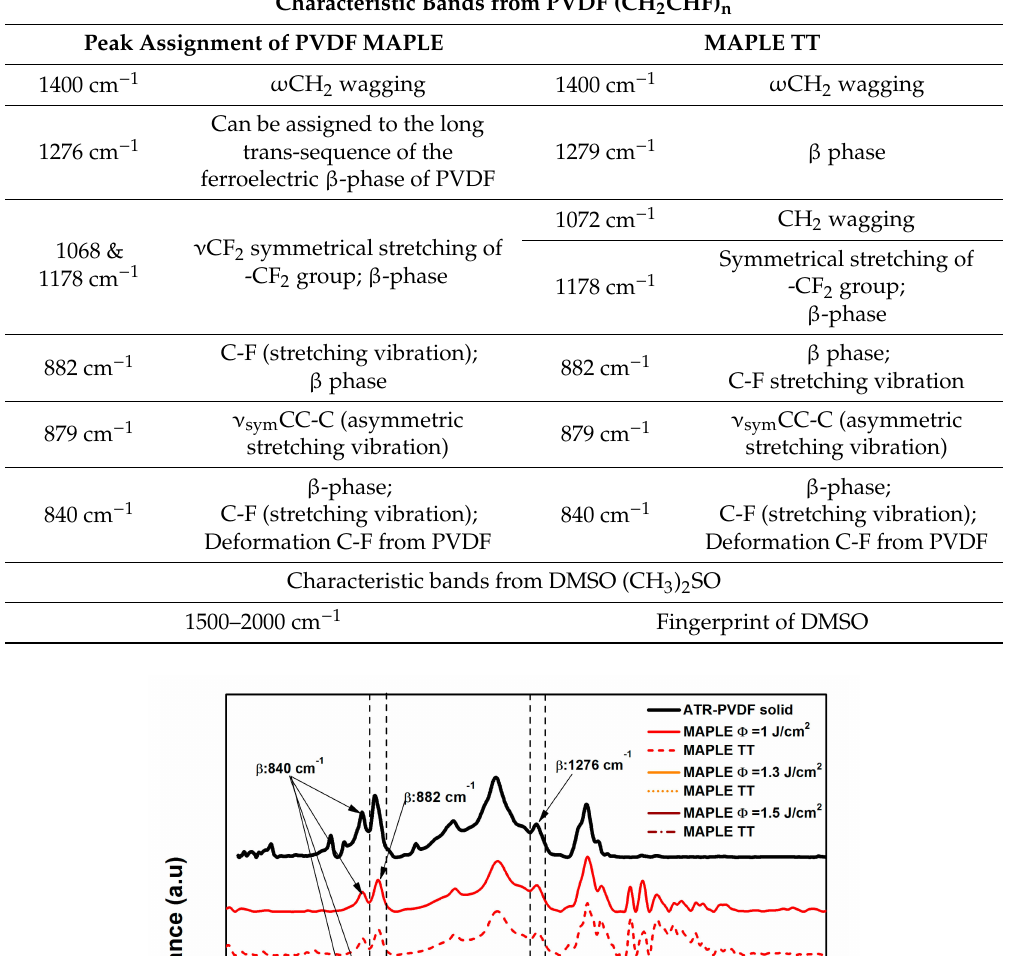
Table 1. Summary of the polyvinylidene fluoride (PVDF) coating bands before and after thermal treatment (TT), as well as the fingerprint of dimethyl sulfoxide (DMSO).